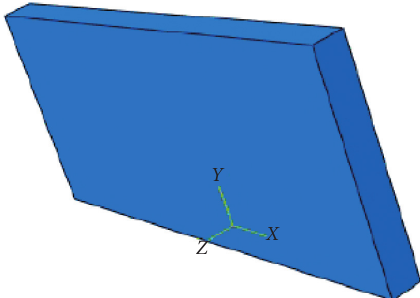
Figure 21: Model of the composite slab.